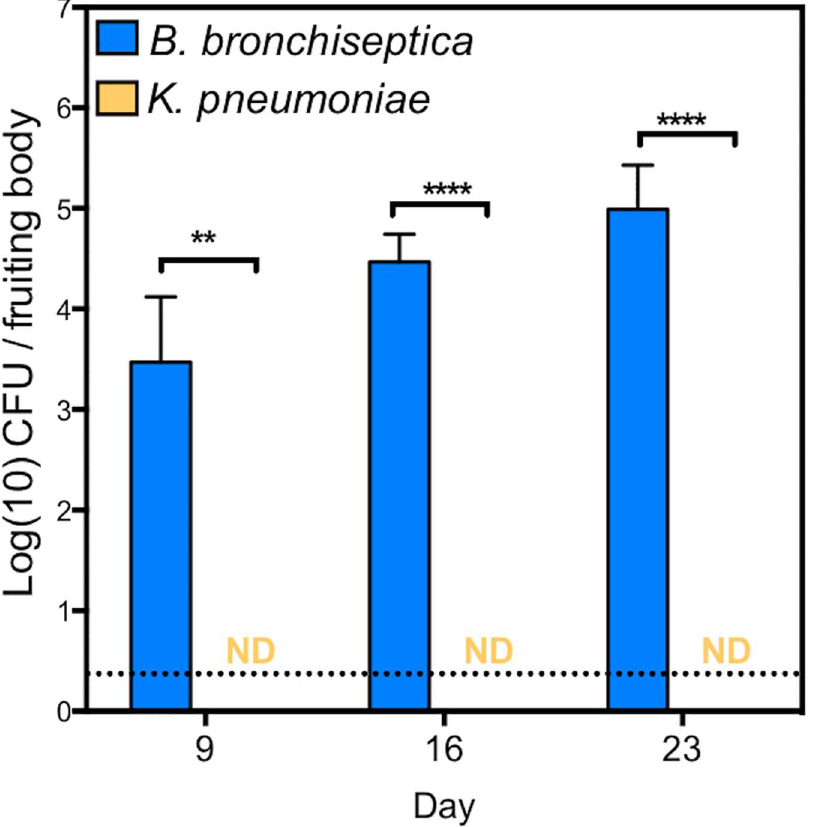
Fig 3. B . bronchiseptica survivesand replicates in amoeba sori. Recovery of B . bronchiseptica (blue) and K . pneumoniae (orange)from D . discoideum sori on days 9, 16, and 23 post additionof amoebaeto lawns of B . bronchiseptica or K . pneumoniae , respectively. ** denotesa p -value < 0.005; **** denotesa p - value < 0.00005. A grey dotted line indicatesthe limit of detection. ND signifies"not detected." CFU, colony forming unit. For further details, please see S1 Data.